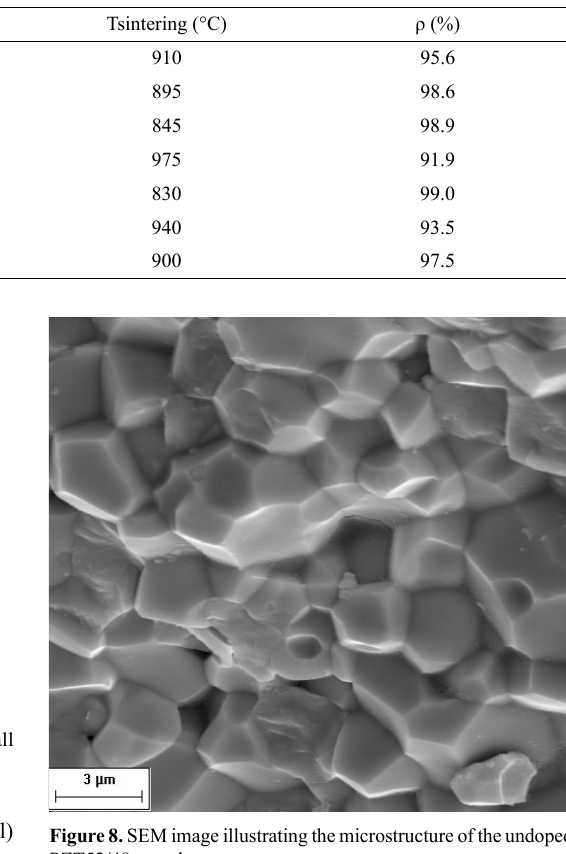
Table 1. Values of retraction temperature, sintering temperatures and relative densities of PZT ceramics.